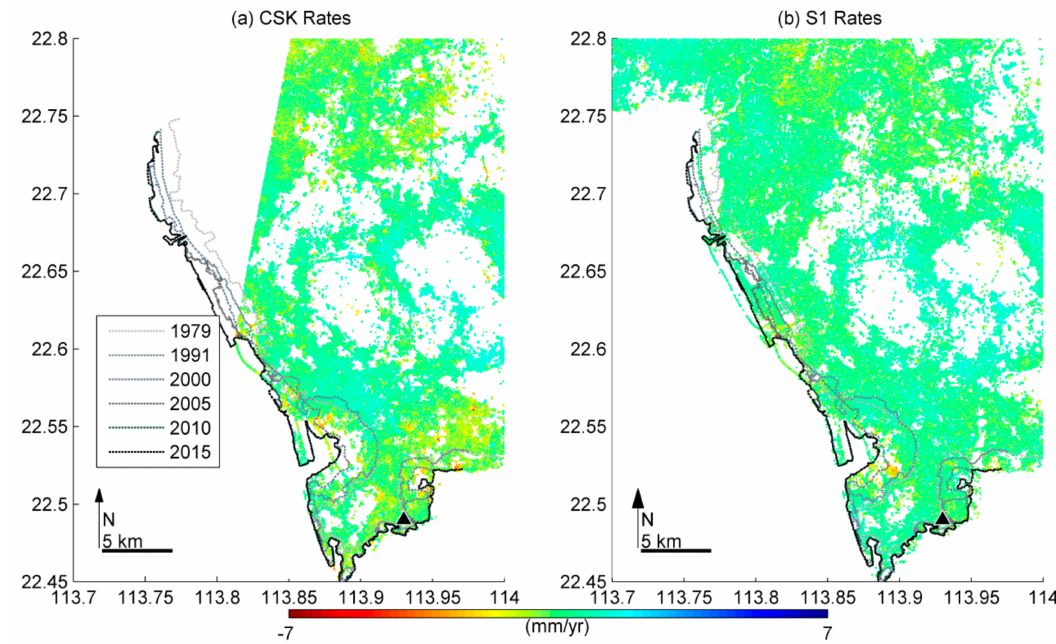
Figure 5. ( a ) Mean rates derived from CSK between 7 December 2013 and 14 January 2016; ( b ) Mean rates from S1 between 15 June 2015 and 28 February 2017. Coastlines are the same as Figure 4. Reference points for CSK and S1A datasets are shown in black